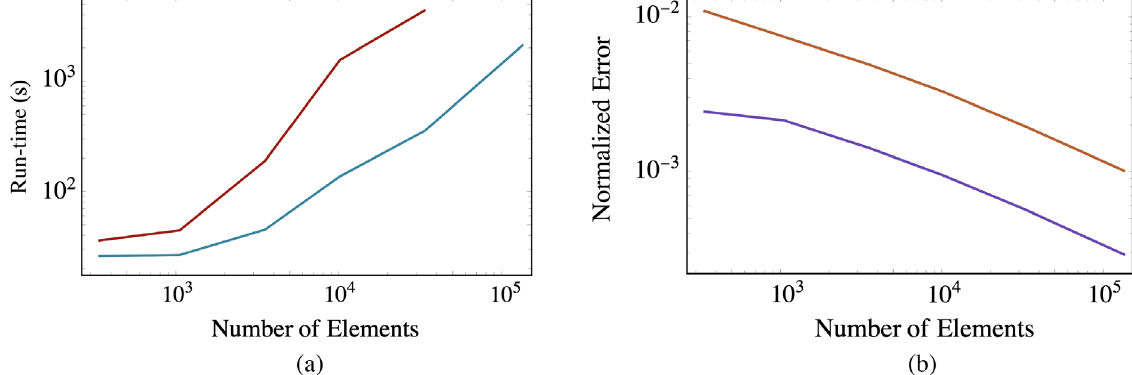
FIG. 9. The left plot shows the computation time for PISCS in serial (red line) and parallel (blue line) operation, and the right plot relates the normalized error in the magnetic potentials (purple line) and fields (orange line) as a function of the number of boundary elements for the magnetic